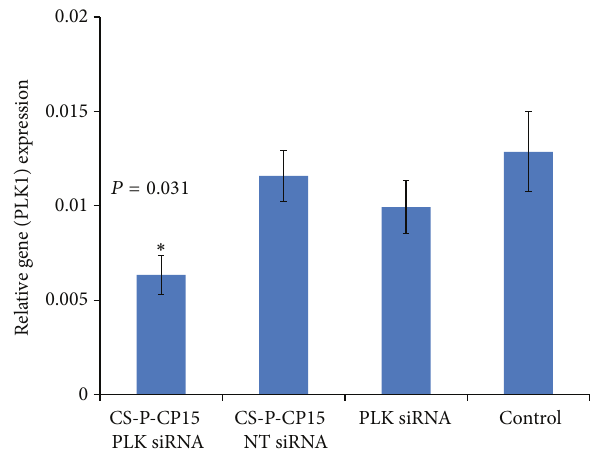
Figure 5: Quantitative PLK1 mRNA analysis in the tumor tissue. The graph represents relative gene expression of PLK1 in tumor tissues, after intraperitoneal administration of various treatment formulations; (i) CS-PEG-CP15 with siRNA against PLK1 gene, (ii) CS-PEG-CP15 with non-targeting biotin-siRNA, (iii) PLK1 siRNA alone, and (iv) control: saline. The PLK1 gene expression was compared among different groups after normalizing the GAPDH levels among all the animals. A 50.7 ± 19.5 % PLK1 gene suppression was observed in treated animals ( 𝑃 = 0.031 ) as compared with untreatedcontrol.Thegraphshowsarepresentativeresultof 𝑛 = 6 in each group, mean ± SE. ∗ 𝑃 < 0.05 was considered significant based on Tukey’s post hoc analysis, when compared with other